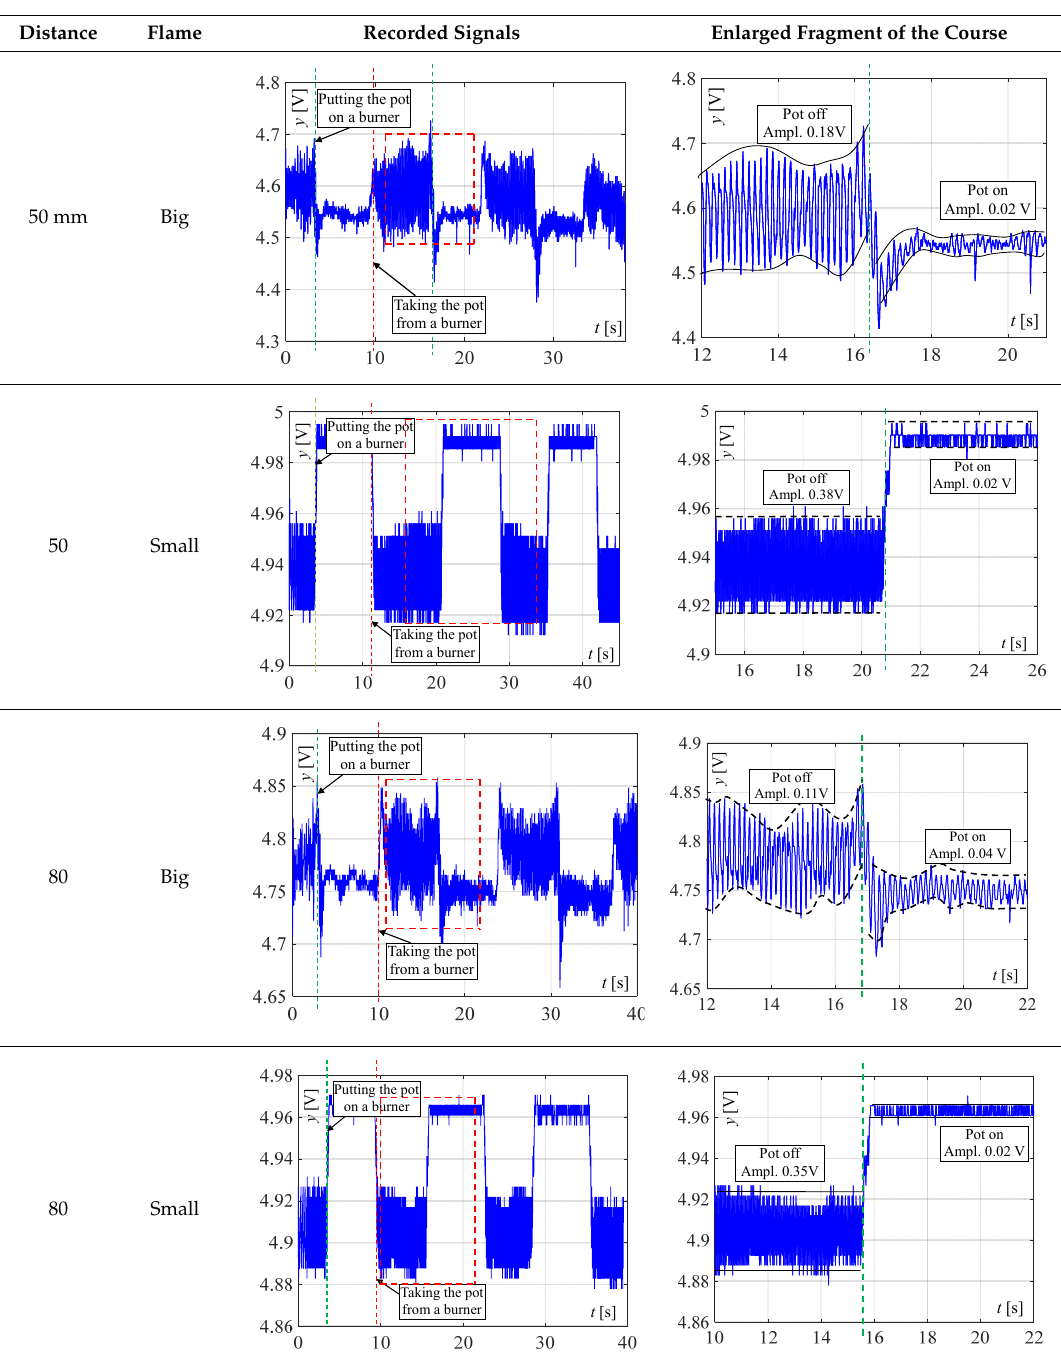
Figure 19. IR diode output signal if the flame is on and off. Table 1. Laboratory investigation results obtained with the use of the IR photodiode.